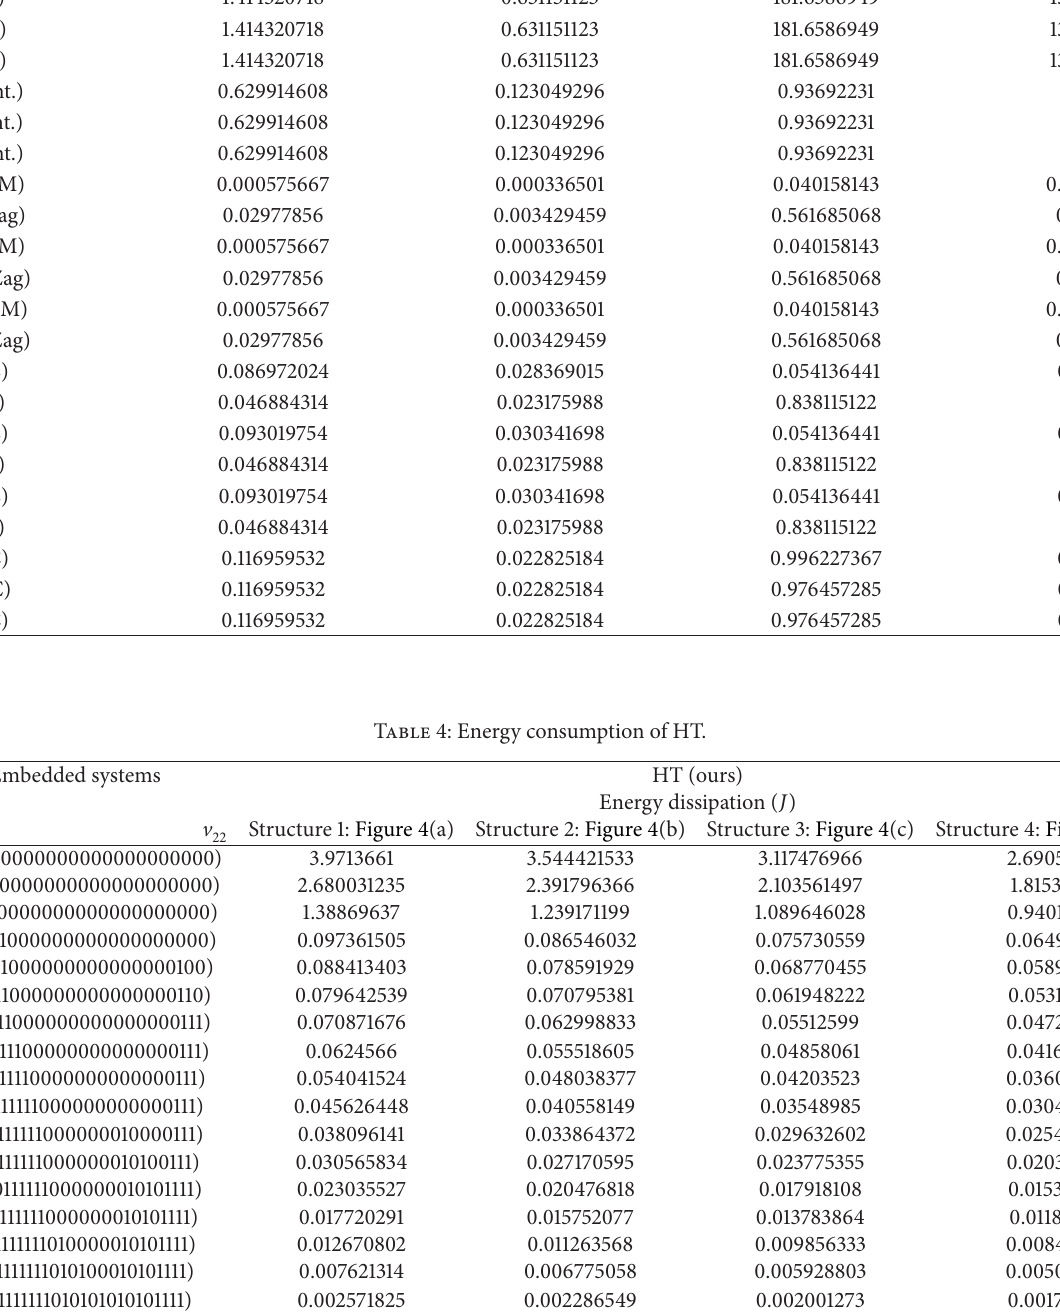
Table 3: Measured data of tasks for JPEG encoding system.